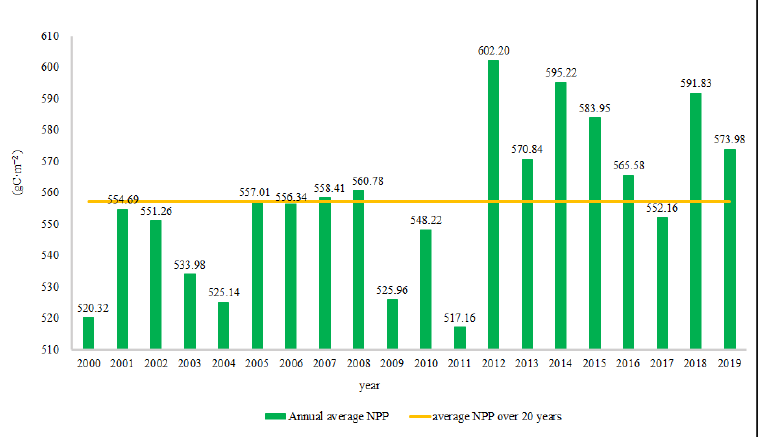
Figure 3. Annual and overall average NPP in protected areas of Sichuan Province (2000–2019).